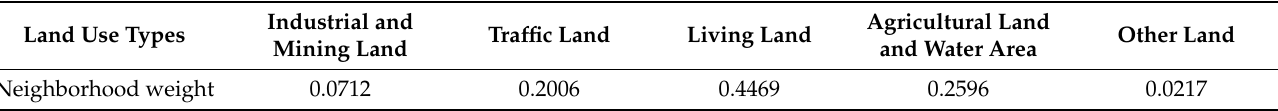
Table A1. Neighborhood weight of each type of land use.